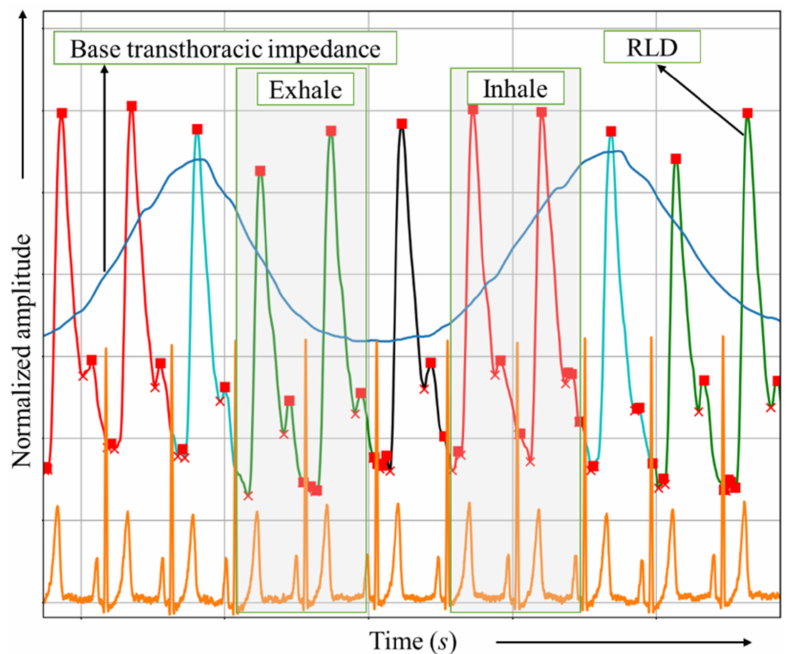
Figure 4. Division of cycles according to the phase of respiration (green—exhale, red—inhale, cyan—end of inhale, black—end of exhale); blue line is the base transthoracic impedance signal, and orange is the ECG signal.